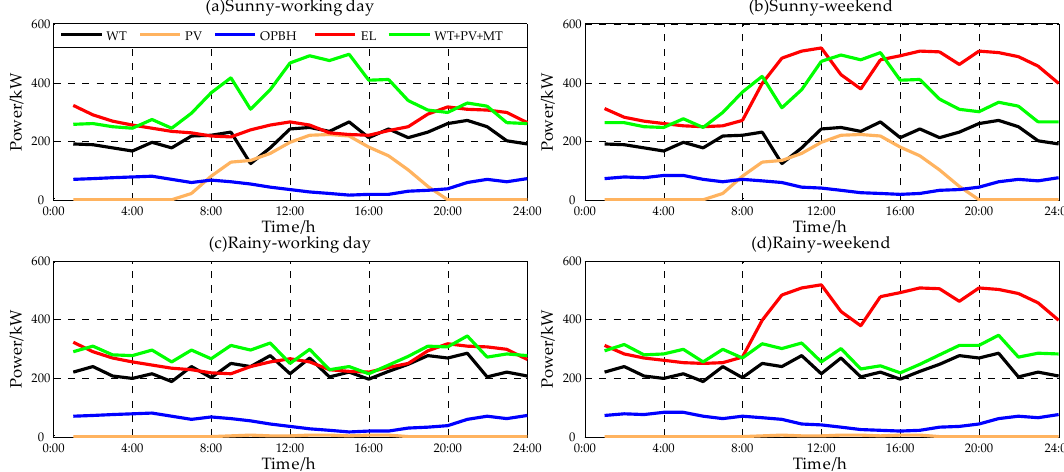
Figure 7. The load demand and output prediction of renewable energy in four scenarios. OPBH: ordering power by heat; EL: electric load.